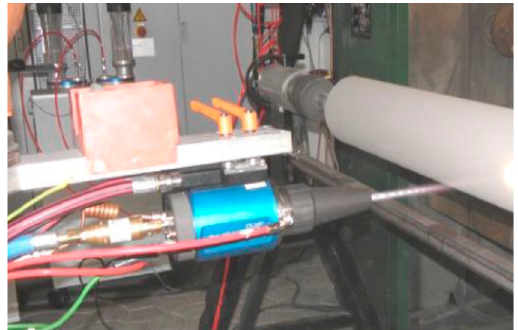
Figure 2. The process of HVOF gun deposition of composite layers. The supersonic gas jet forms the stationary shock waves in the plasma jet.